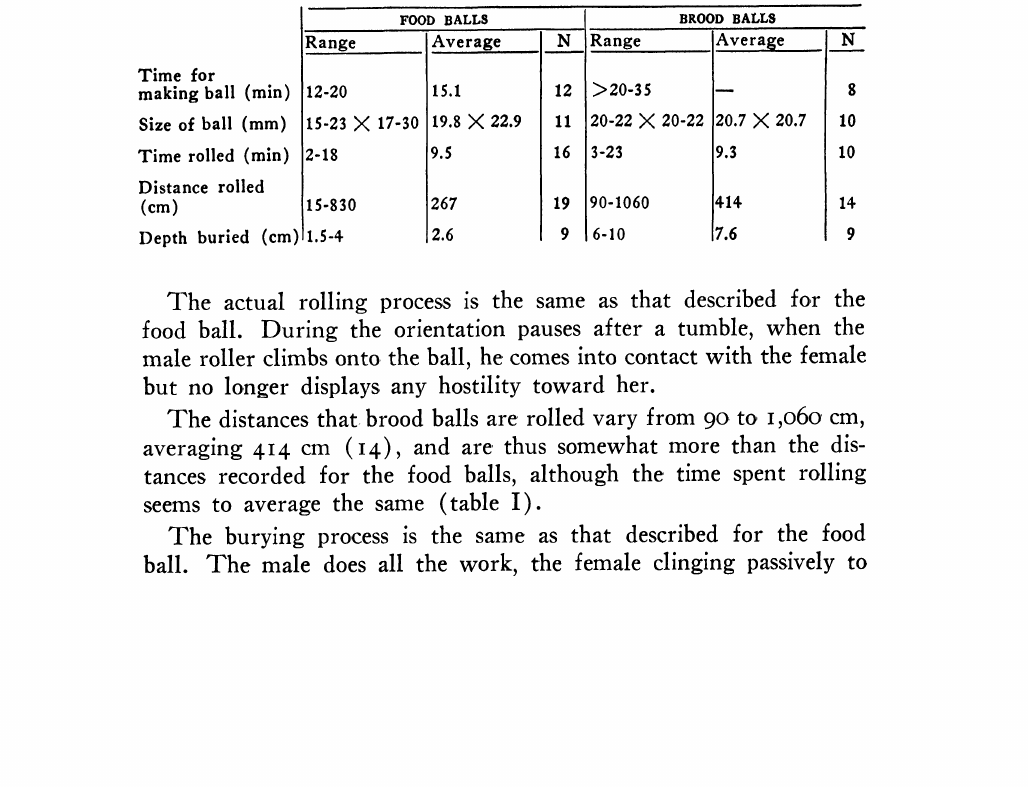
Table I. Data on dung balls made by Ganthon lilularius